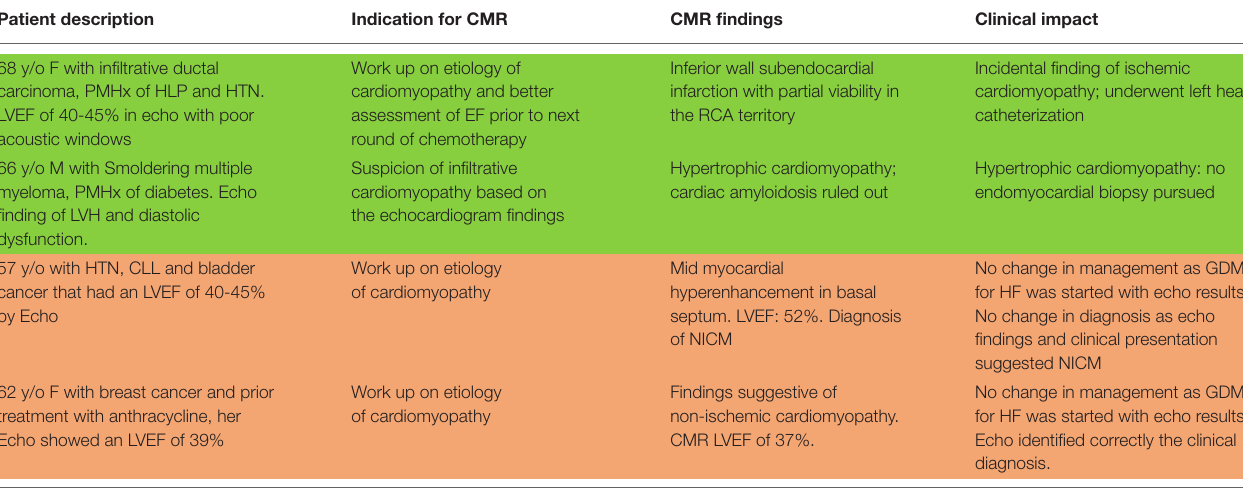
TABLE 5 | Examples of patients with (green) and without (red) changes in both diagnosis and management after CMR. Patient description